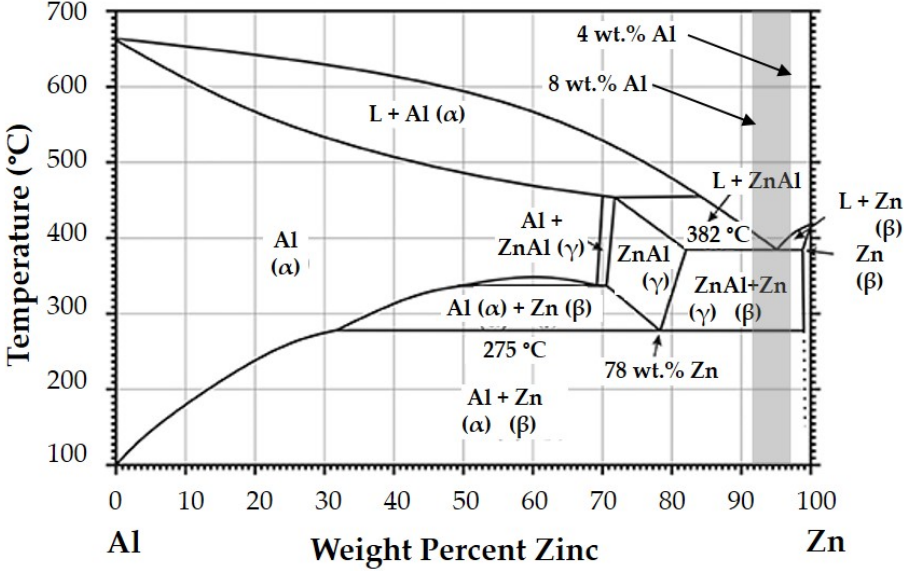
Figure 4. Phase diagram of binary Zn–Al alloy [36] modified through adding a shaded area.